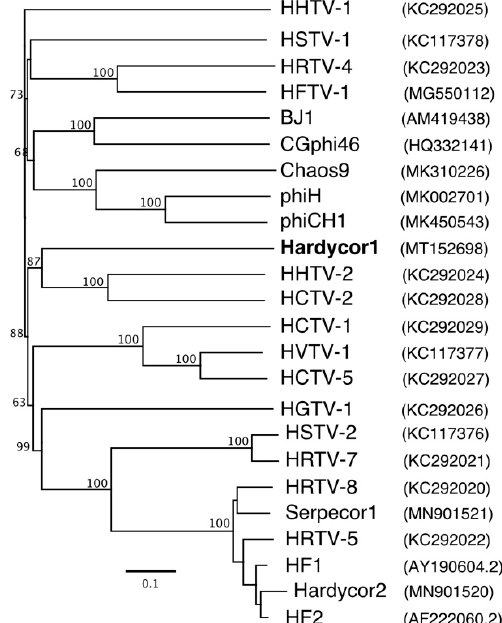
Figure 5. Phylogenetic tree reconstruction of tailed haloviruses inferred from viral proteomes using the Genome-BLAST Distance Phylogeny method (GBDP) under optimal settings (formula VICTOR d6), as implemented at the DSMZ webserver [42,64]. Percentage support values above 60% are shown near the branch points. The branch lengths are scaled in terms of the GBDP distance formula d6 [42]. Tree scale (0.1) is indicated by the bar. Accessions are given at the right in brackets.